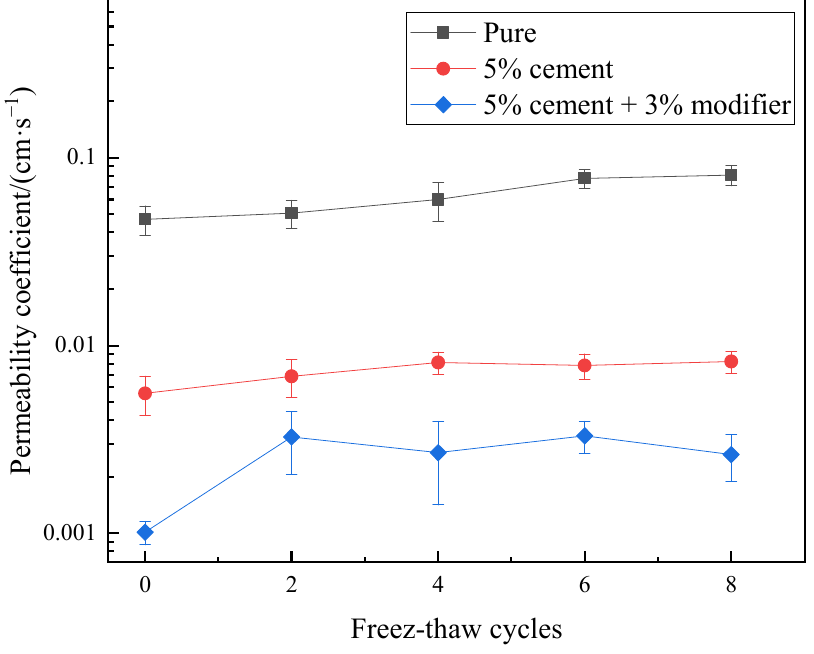
Figure 6. Influence curves of freeze–thaw cycles on permeability coefficient.